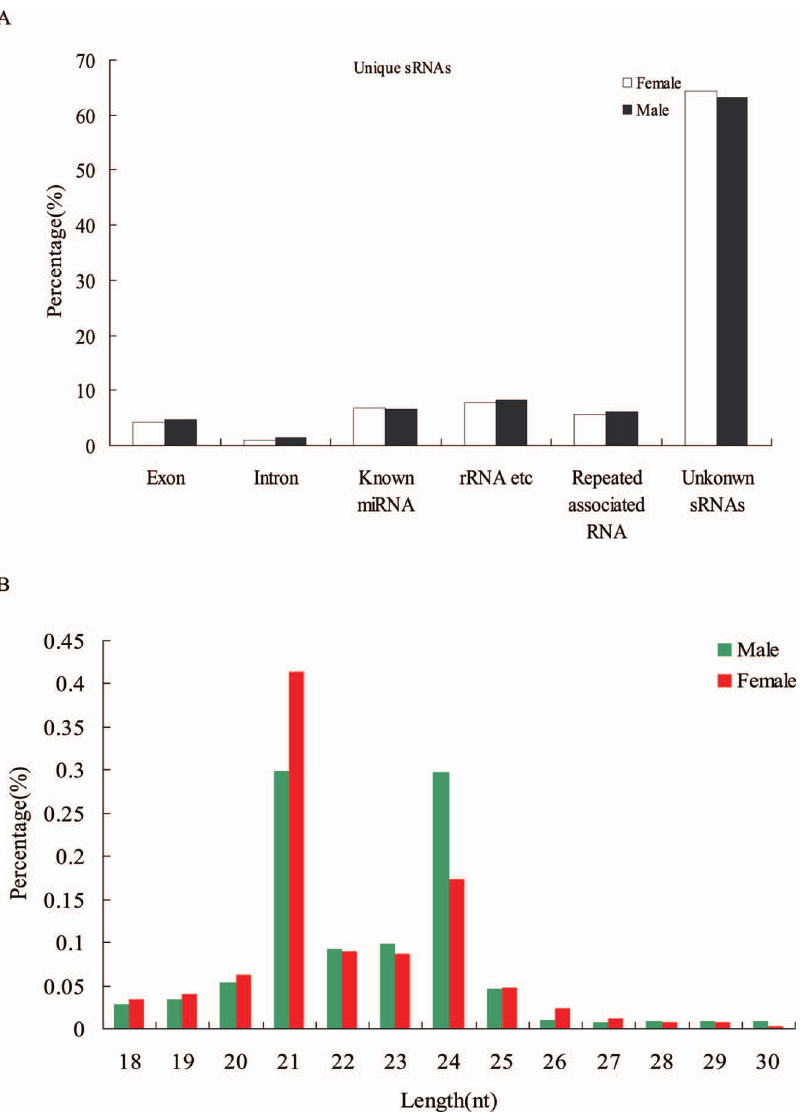
Figure 1. Small RNAs from female and male flower libraries in andromonoecious poplar. (A) Distribution of unique sRNA annotation categories. (B) Size distribution of small RNA reads.